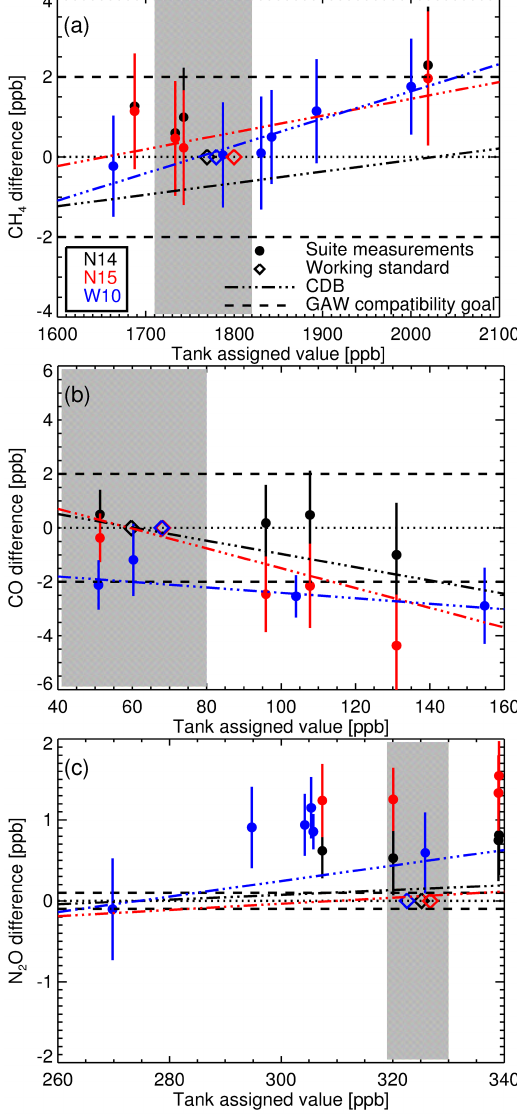
Figure 9. Complete-IRF linear fit residuals (with 1 σ uncertainty bars) from measurements of multi-tank suites, N14, N15 and W10.